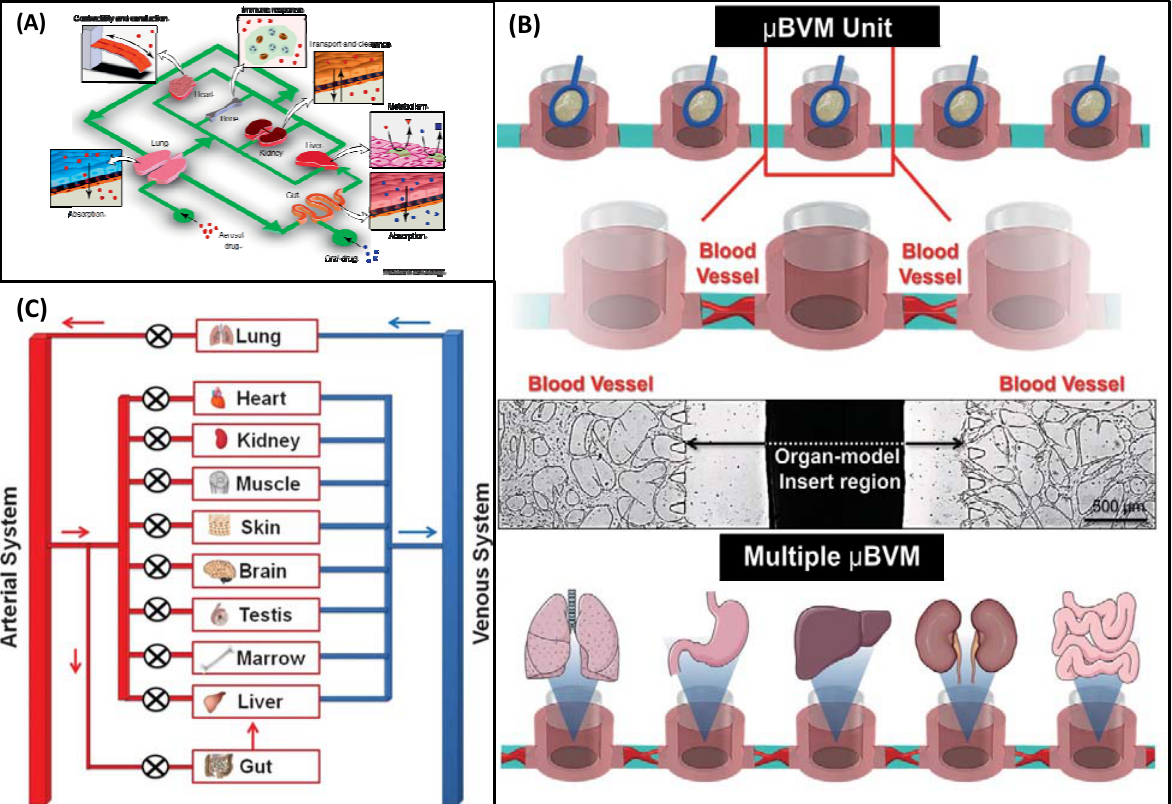
Figure 8. Schematic of a human on a microfluidic chip: ( A ) An integrated system composed of micro ‐ organs. The image from [51], Copyright 2011, Elsevier. ( B ) Integrated system of multiple culture dishes connected by perfusable vessels. The image from [52], Copyright 2015, SAGE. ( C ) Integrated system of different organ ‐ on ‐ a ‐ chip couplings. The image from [53], Royal Society of Chemistry.